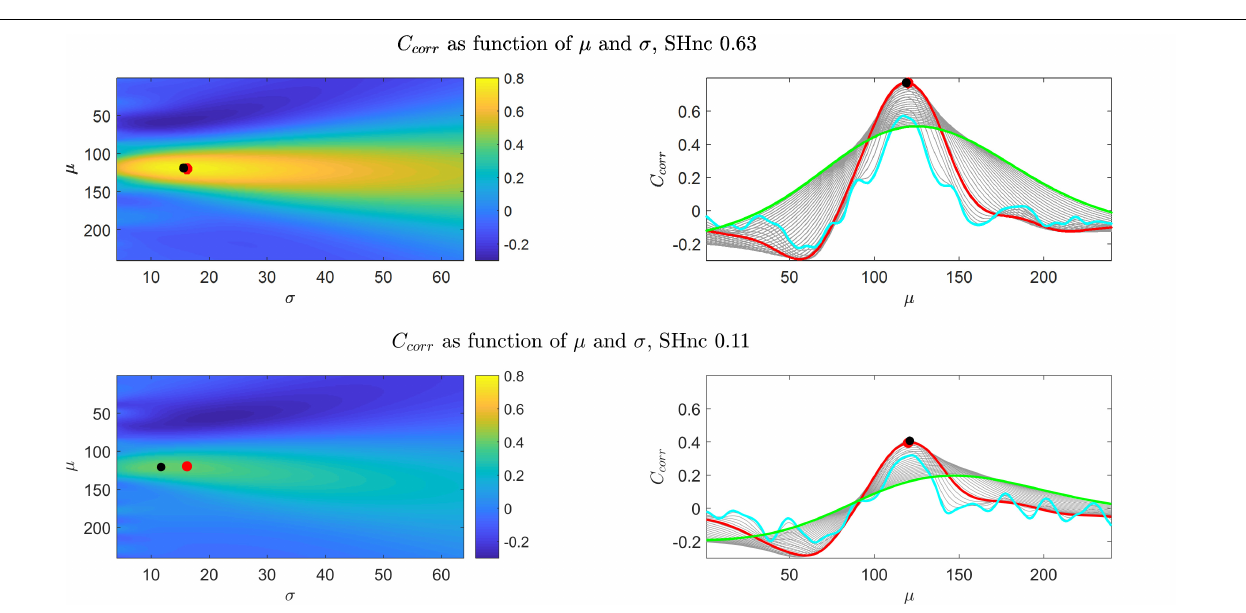
Supplementary Figure S2 . Both when using the correlation